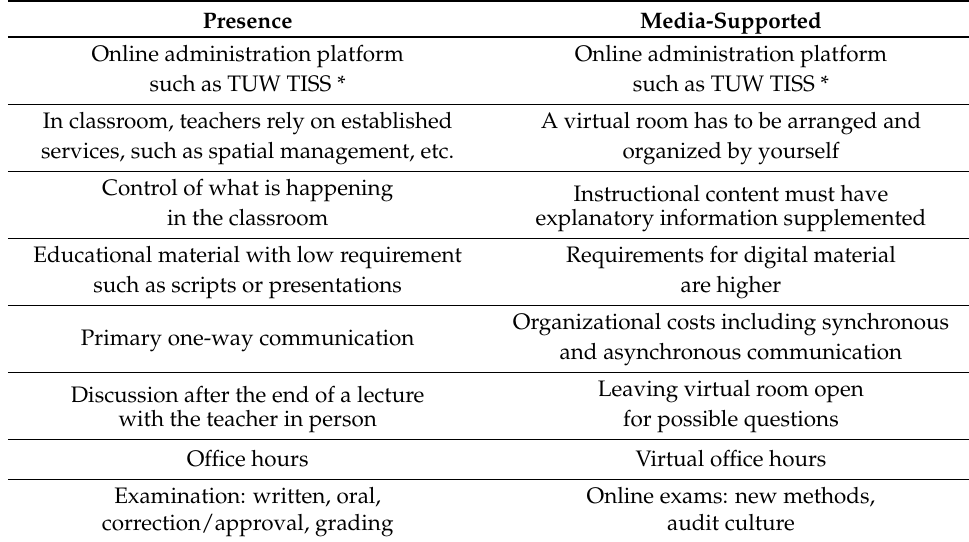
Figure 1. Four elements of media-supported teaching (as in [3]). Table 1. Aspects on the way from presence teaching towards media-supported teaching (after